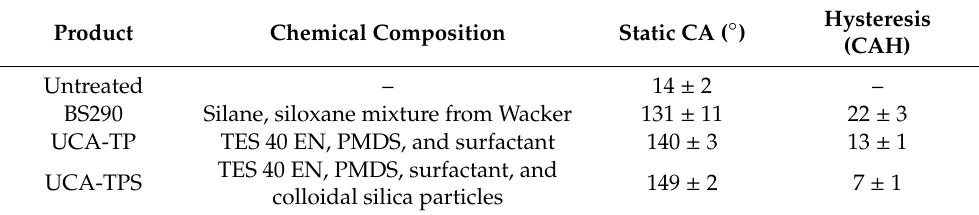
Table 1. Static contact angle (CA) values and contact angle hysteresis (CAH) for untreated and treated stones as reworked from [86]. Adapted with permission from [86], copyright (2013) American Chemical